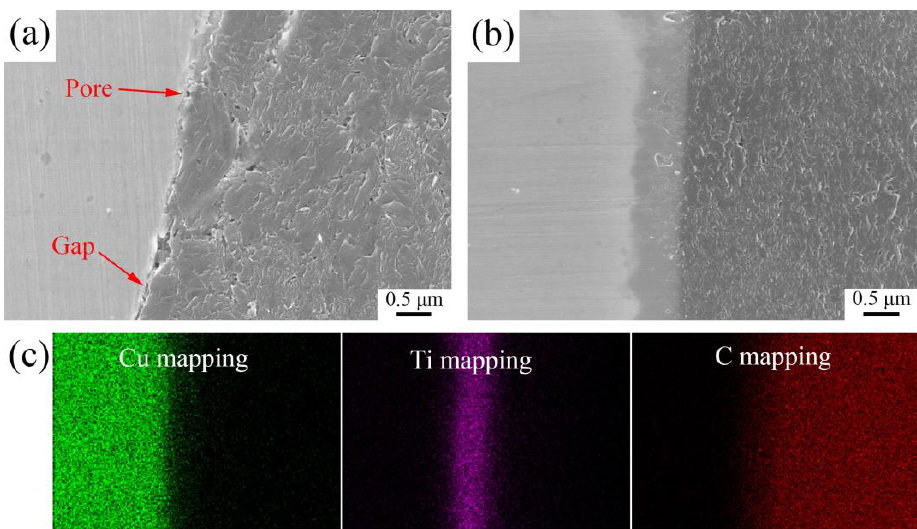
Figure 6. ( a ) Interfacial morphology of graphite flake/Cu composite, ( b ) Interfacial morphology of TiC-coated graphite flake/Cu composite; and ( c ) the element distribution in ( b ).